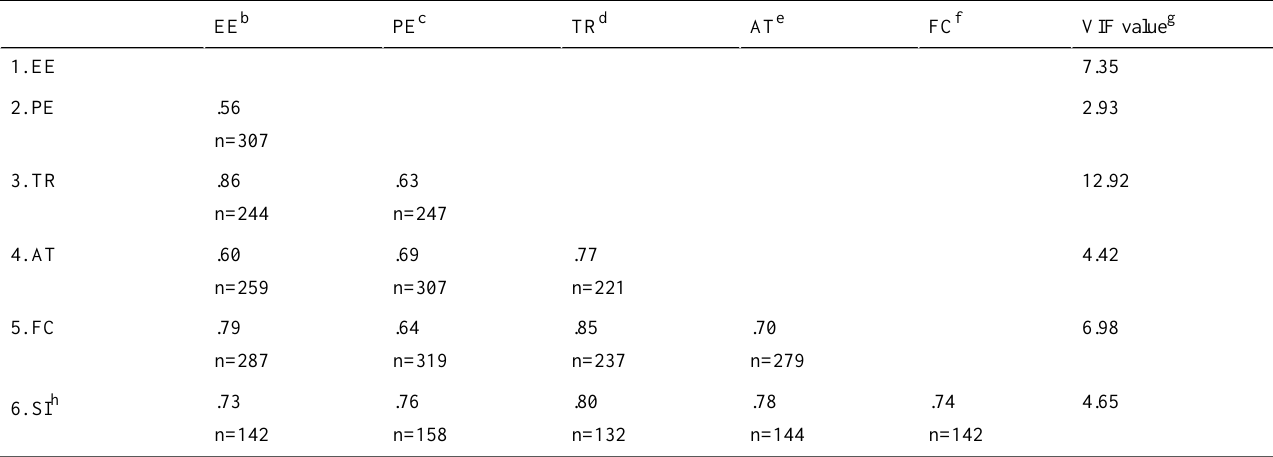
Table 3. Matrix of linear correlations and variance inflation factor values between the independent constructs that could influence intention to ask questions by Internet via email or a website. a